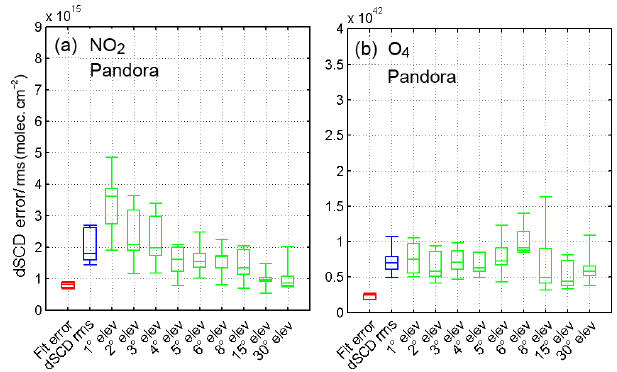
Figure 16. Same as Fig. 14, but for Pandora instruments